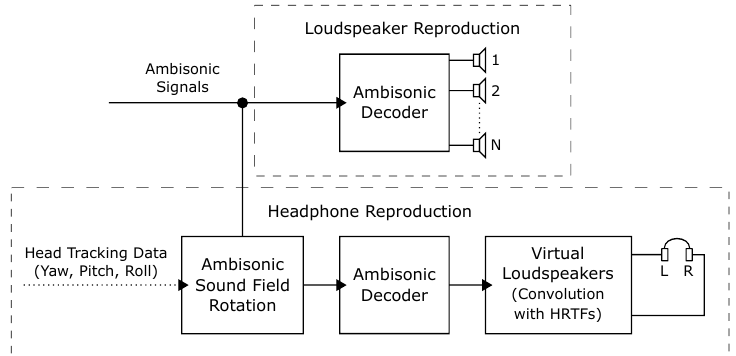
Figure 2. Block diagram illustrating audio signal chain for Ambisonic rendering over loudspeakers and